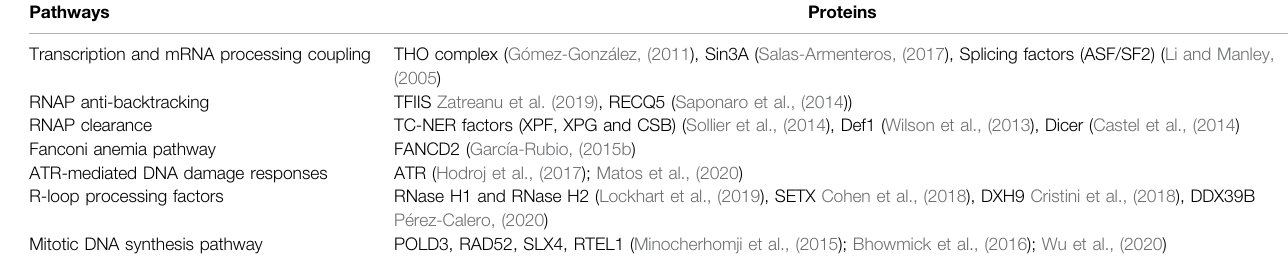
TABLE 1 | Key proteins involved in preventing or resolving transcription associated RS. Pathways Proteins